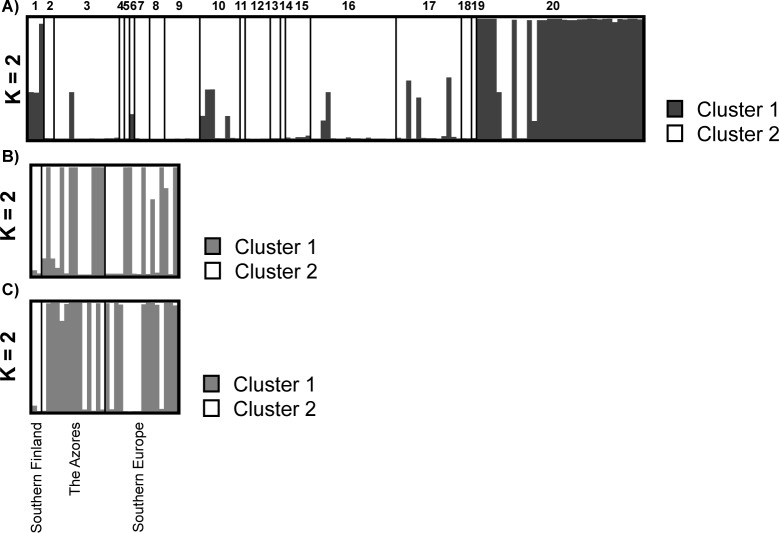
Population clusters obtained from multilocus analyses using STRUCTURE.The vertical bars represent the individuals, the colors indicate the proportion of the genome assignable to each cluster. Populations are separated by vertical black lines. (A) Resulting clusters of H. bachmannii on all host species. The numbers represent the different hosts: 1. C. cervicornis, 2. C. crispata, 3. C. gracilis, 4. C. cornuta, 5. C. macroceras, 6. C. granulosa, 7. C. foliacea, 8. C. glauca, 9. C. ramulosa, 10. C. uncialis, 11. C. phyllophora, 12. C. pyxidata, 13. C. mitis, 14. C. stygia, 15. C. coniocraea, 16. C. furcata, 17. C. stereoclada, 18. C. squamosa, 19. C. macilenta and 20. C. rangiformis; (B) Resulting clusters of H. bachmannii collected on C. rangiformis; (C) Resulting clusters of C. rangiformis parasitized by H. bachmannii.